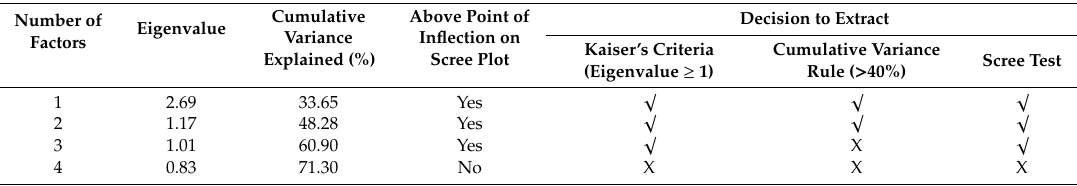
Table 3. Summary of the factor extraction measures used in exploratory factor analysis of the Athens Insomnia Scale (AIS) scores in Indian computer professionals.